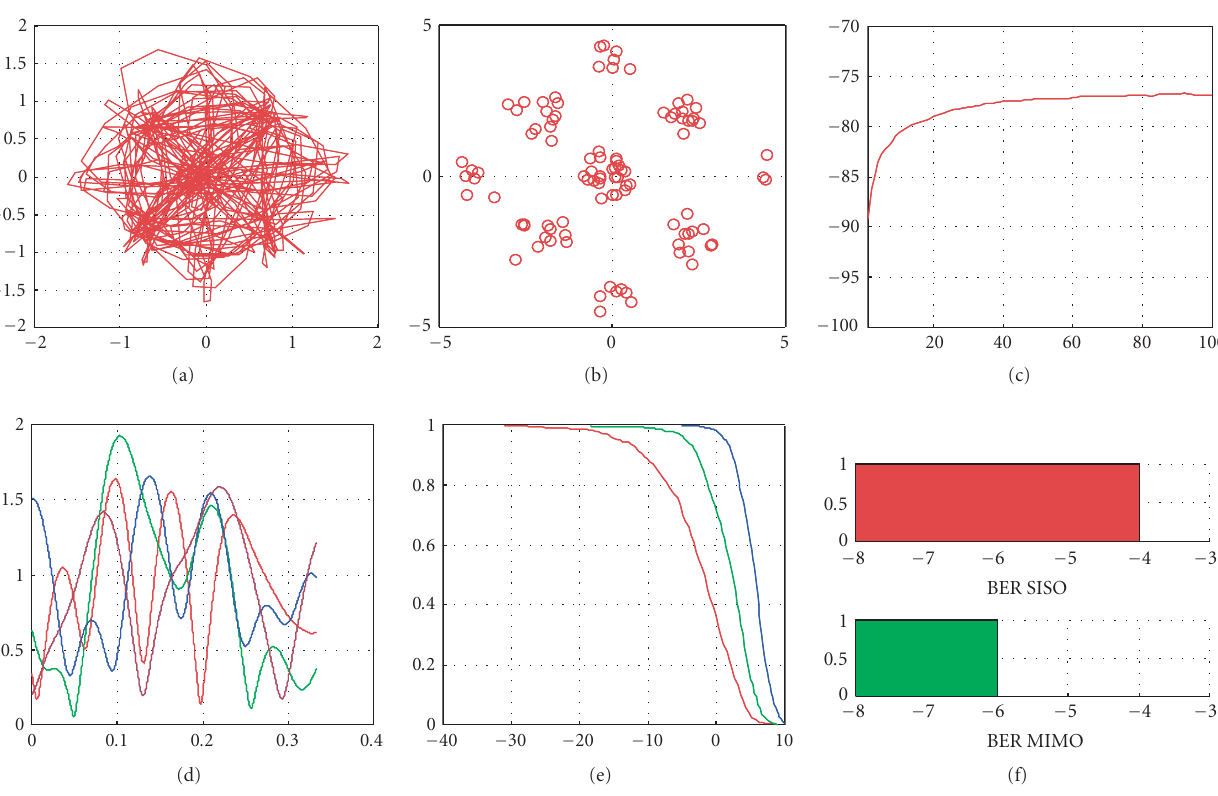
Figure 8: Host computer display. ((a) MF output, (b) STP output, (c) automatic gain control, (d) MIMO channel estimation, (e) diversity advantage, and (f) bit error